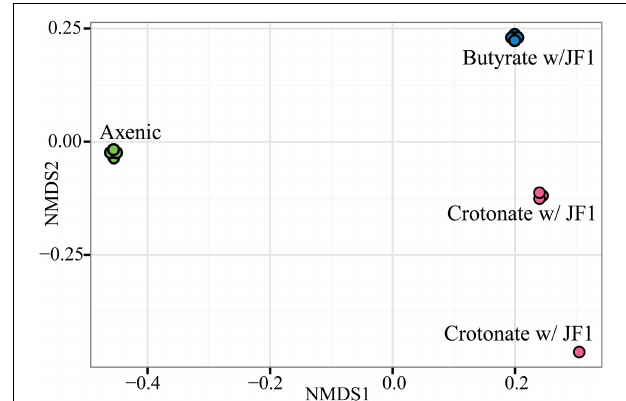
FIGURE 1 | Non-metric multidimensional scaling of the S. wolfei protein profiles obtained from each technical replicate for each duplicate culture grown under the three conditions. Symbols: green circle, S. wolfei pure culture on crotonate; pink circles, S. wolfei-M. hungatei coculture on crotonate; blue circles, S. wolfei-M. hungatei coculture on butyrate.